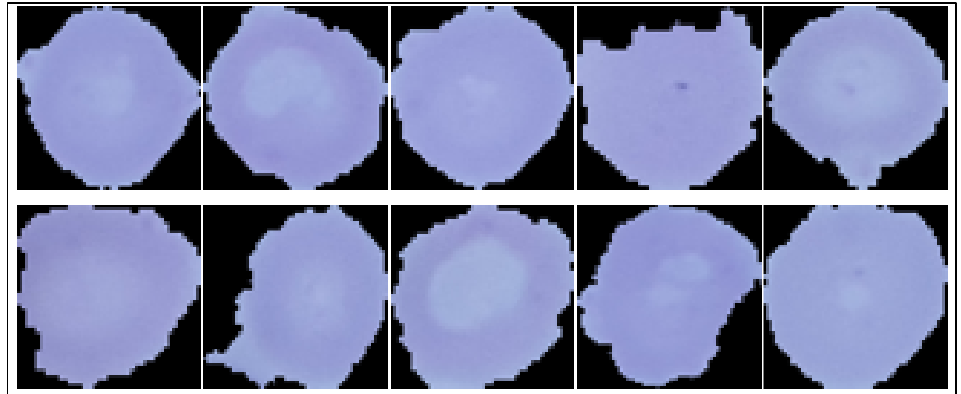
Figure 2. Uninfected cell images.